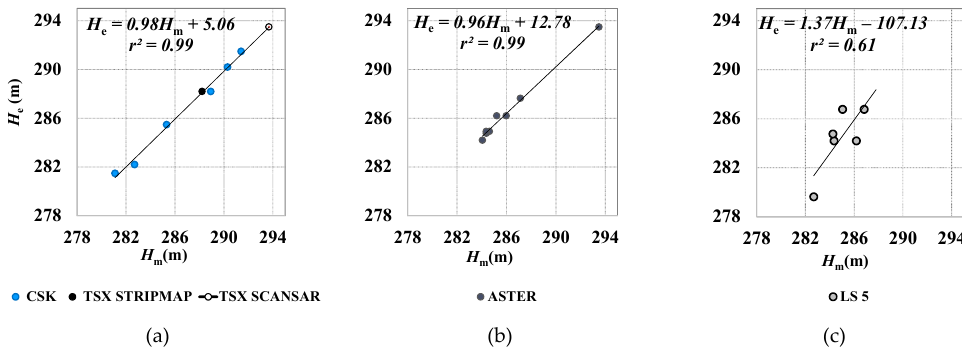
Figure 6. Water level measured in situ ( H m ) versus levels obtained by visual matching technique ( H e ) using: ( a ) SAR; ( b ) ASTER and ( c ) LS5.